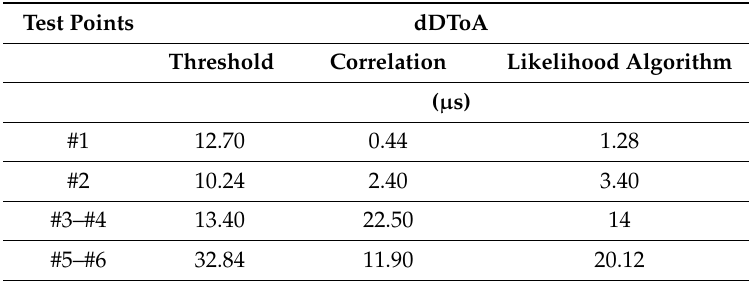
Table 2. Evaluation of the differences between DToAs